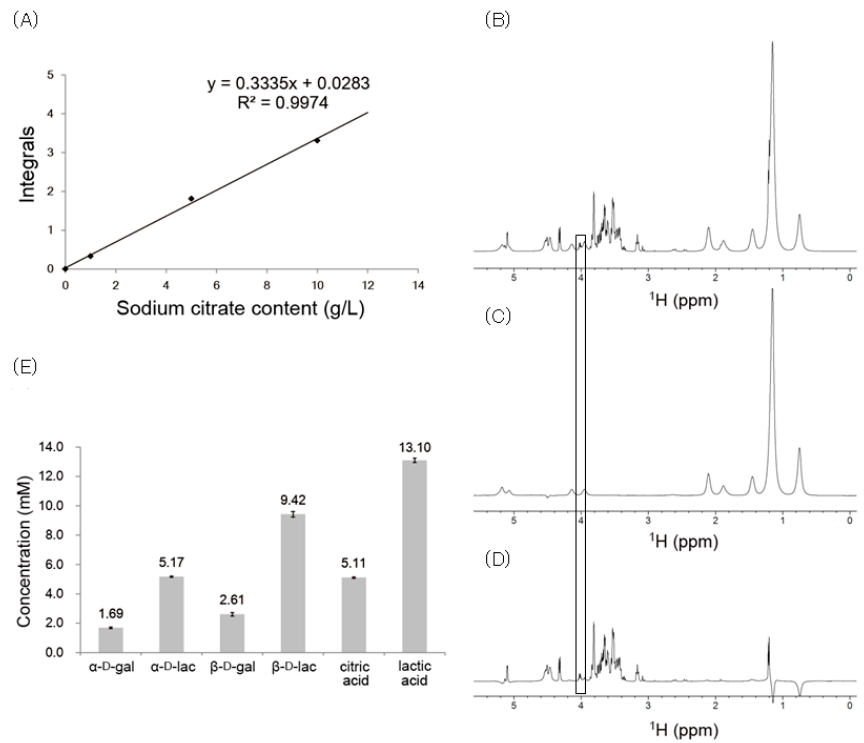
Figure 4. ( A ) Working curves of citrate for the 1 H NMR spectrum. The integral value of the signal arising from the protons of 1,1,2,2-tetrachloroethane was set to 100. ( B ) Quantitative 1 H NMR spectrum of yogurt. ( C ) DOSY NMR spectrum of yogurt. ( D ) The difference spectrum for quantifying the integral of the signal at 4.08 ppm between ( B ) and ( C ). ( E ) Concentrations of yogurt components quantified using the 1 H NMR signals. The standard deviation is shown in parentheses ( n = 3). Gal and lac are abbreviations for galactose and lactose, respectively.